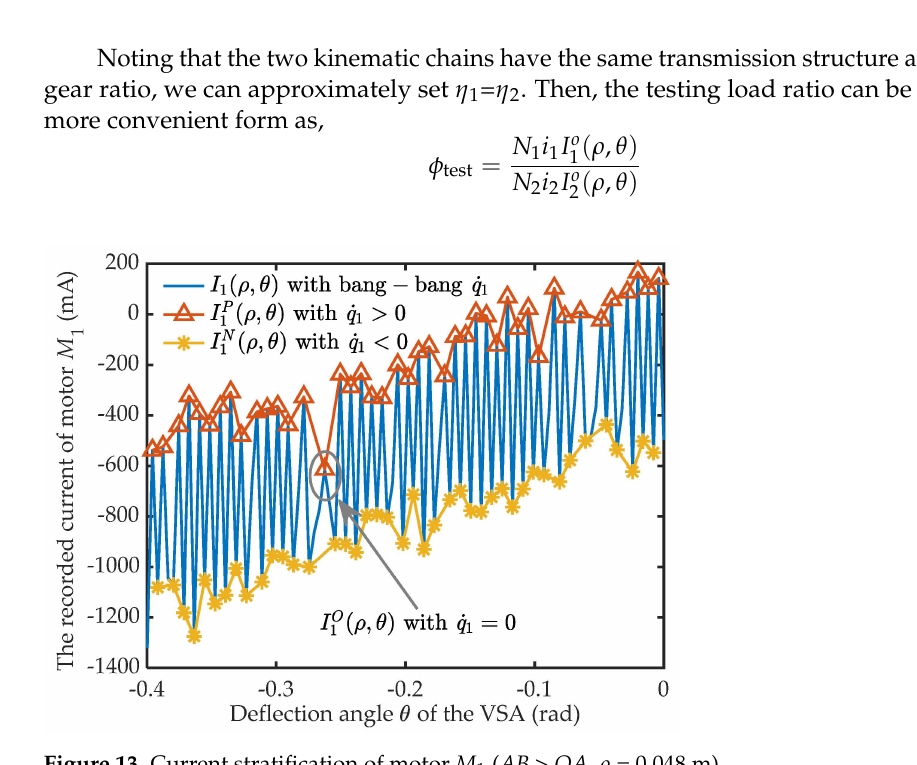
Figure 13. Current stratification of motor M 1 ( AB > OA , ρ = 0.048 m).